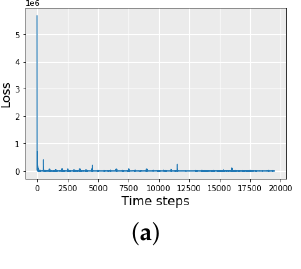
Figure 6. Loss convergence of the DQN algorithm in a heterogeneous MAS, including N = 5 agents in P = 3 different clusters, during 20,000 time steps. ( a ) DQN average loss in a leaderless MAS. ( b ) DQN average loss in a leaderless MAS by considering time-delay. ( c ) DQN average loss in a leader-follower MAS. ( d ) DQN average loss in a leader-follower MAS by considering